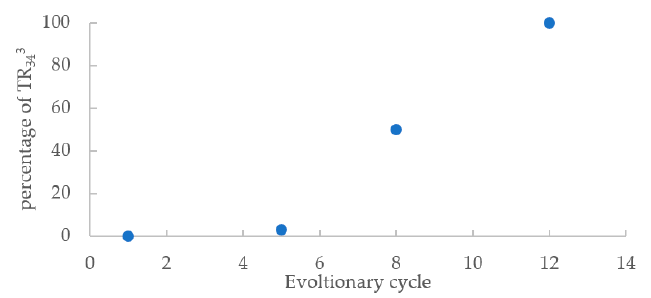
Figure 1. The percentage of isolates harboring TR 343 /L98H over the evolutionary cycle.